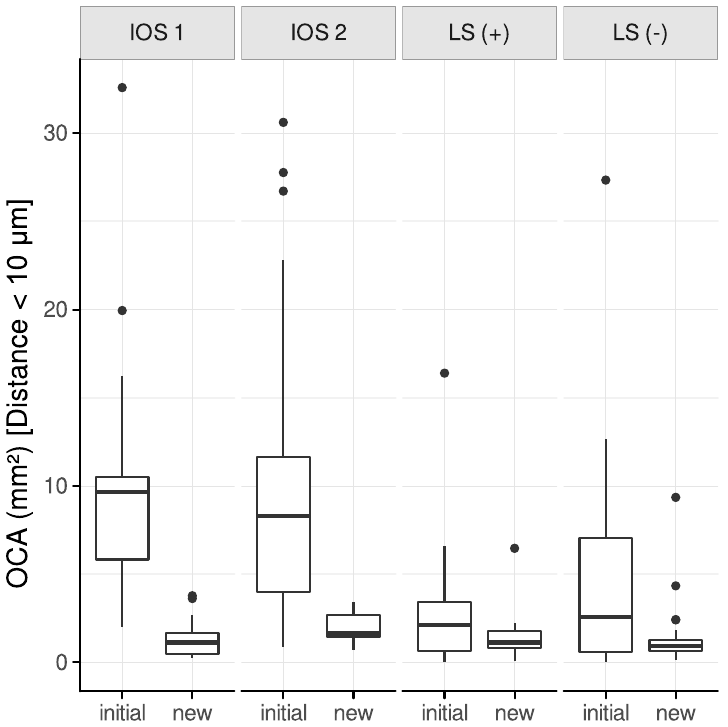
Figure 6. OCA between initial and new alignment of all modalities (partial-arch scans) restricted to a distance of 10 μ m. distance of 10 µ